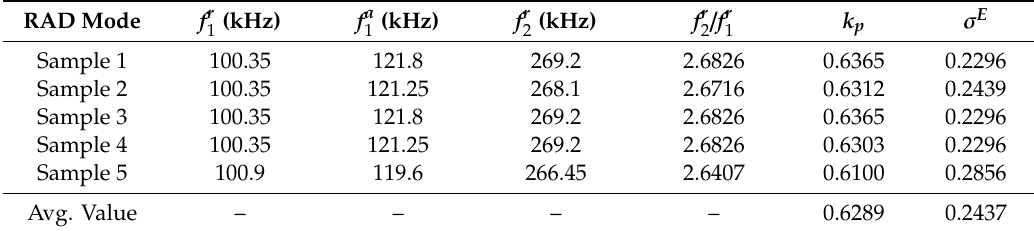
Table 7. Resonant and anti-resonant frequencies and the converted material constants in radial extension (RAD)